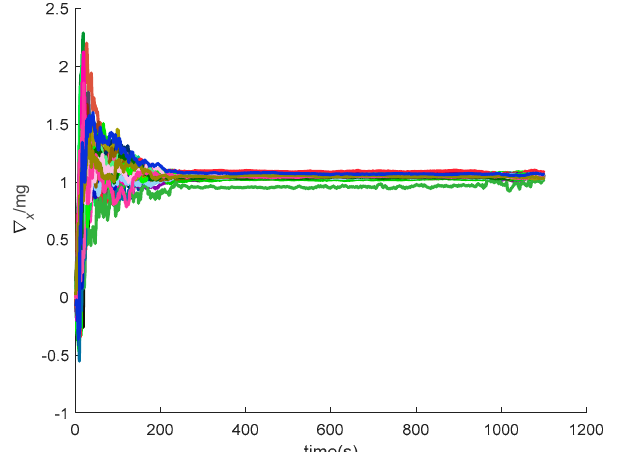
Figure 27. The z -axis gyroscope constant drift of SINS/GPS in the LCEF frame.